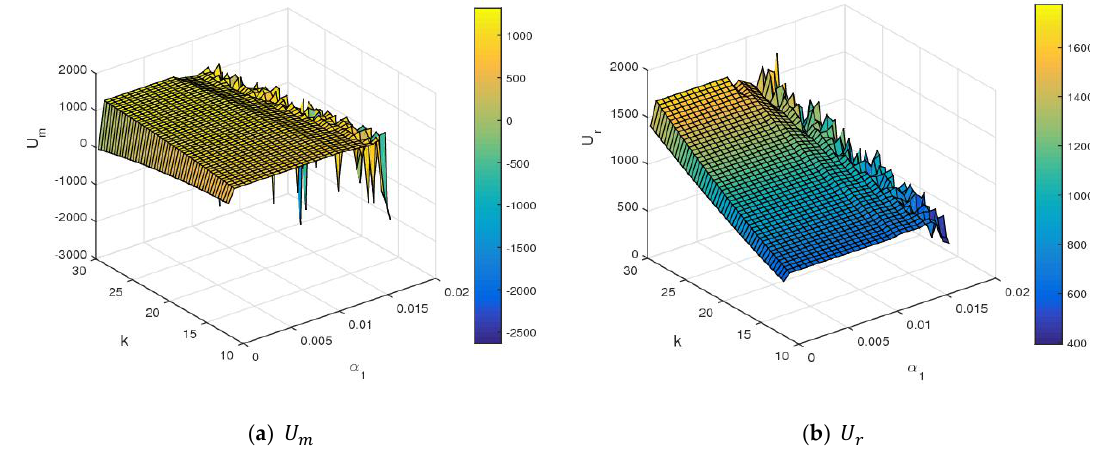
Figure 15. The utility changes of the manufacturer and retailer with respect to 𝛼 1 and 𝜆 2 .